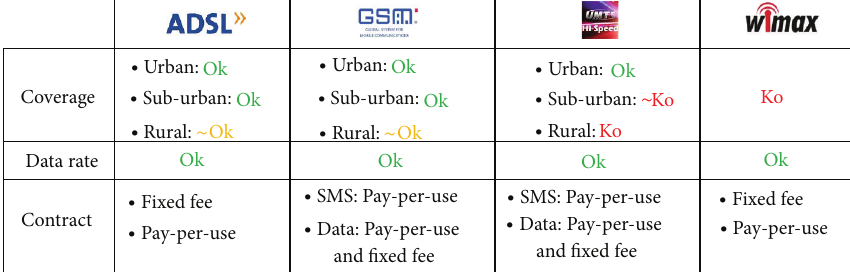
Figure 3: Comparison among communication technologies for home gateway.